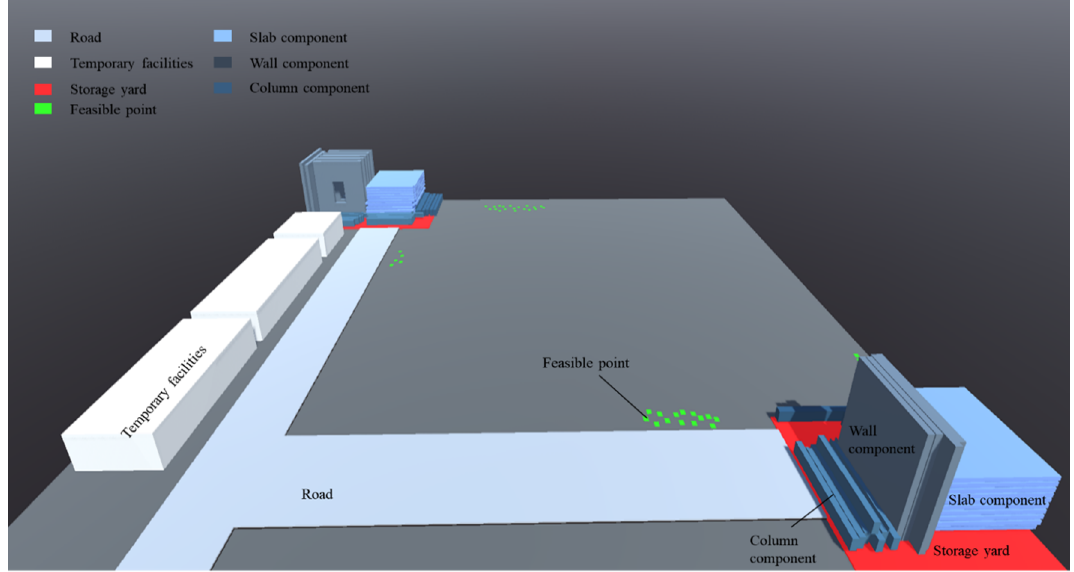
Figure 8. Feasible location points for a certain component (crane type QY100K-I).